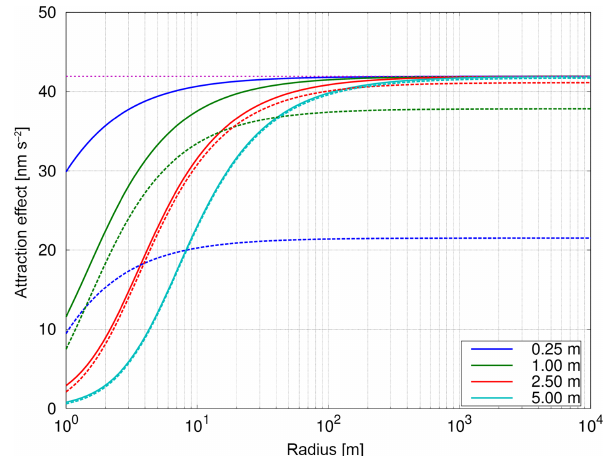
Figure 6. Gravity effect of a homogenous cylinder with a thickness of 10cm, a density of 1000kgm − 3 and varying radii on a sensor placed at different heights (0.25 to 5m) above the cylinder (solid lines). Dashed lines show the same gravity effects but are reduced for a cylinder with a radius of 0.5m and a depth of 1.2m, corre- sponding to the dimensions of the pillar used for the installation of iGrav006 at Wettzell. The dashed purple line indicates the gravity effect of the cylinder with infinite